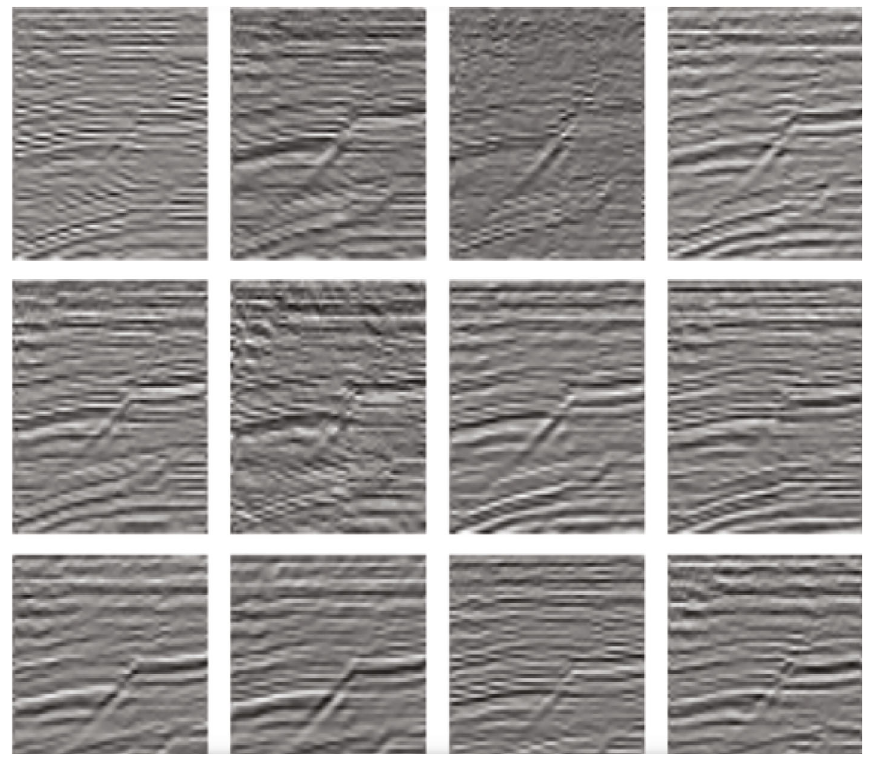
Figure 7: MobileNet V2 feature